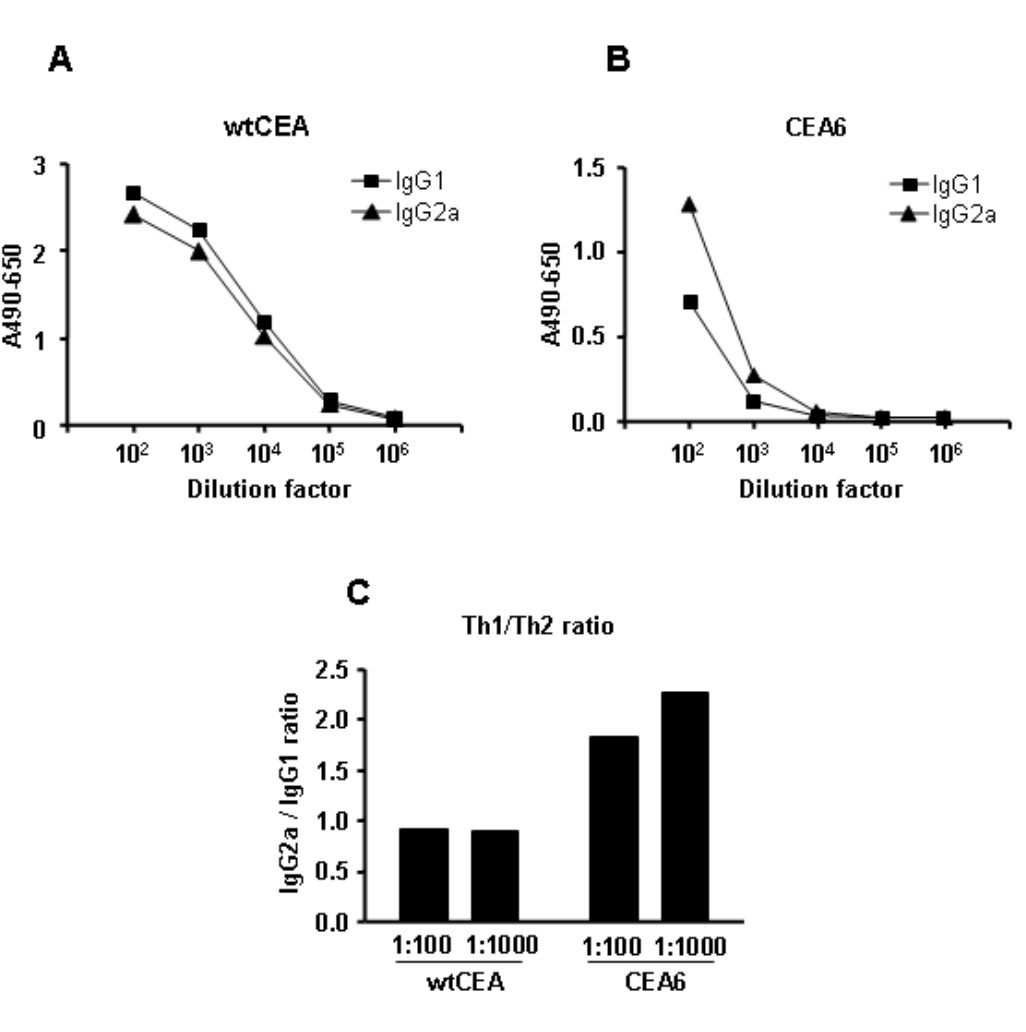
FIGURE 6. Cytoplasmic antigen localization tilts the antibody response to CEA towards a Th1 profile. Three weeks after the third immunization, serum was collected and pooled before analyzed for CEA-specific IgG1 and IgG2a antibodies. The levels of CEA-specific antibodies of IgG1 and IgG2a subclasses from animals immunized with wtCEA (A) and CEA6 (B) were determined. The IgG2a/IgG1 subclass ratio at serum dilutions of 1:100 and 1:1000 are shown in panel C. One representative experiment out of two performed is shown in the figure.